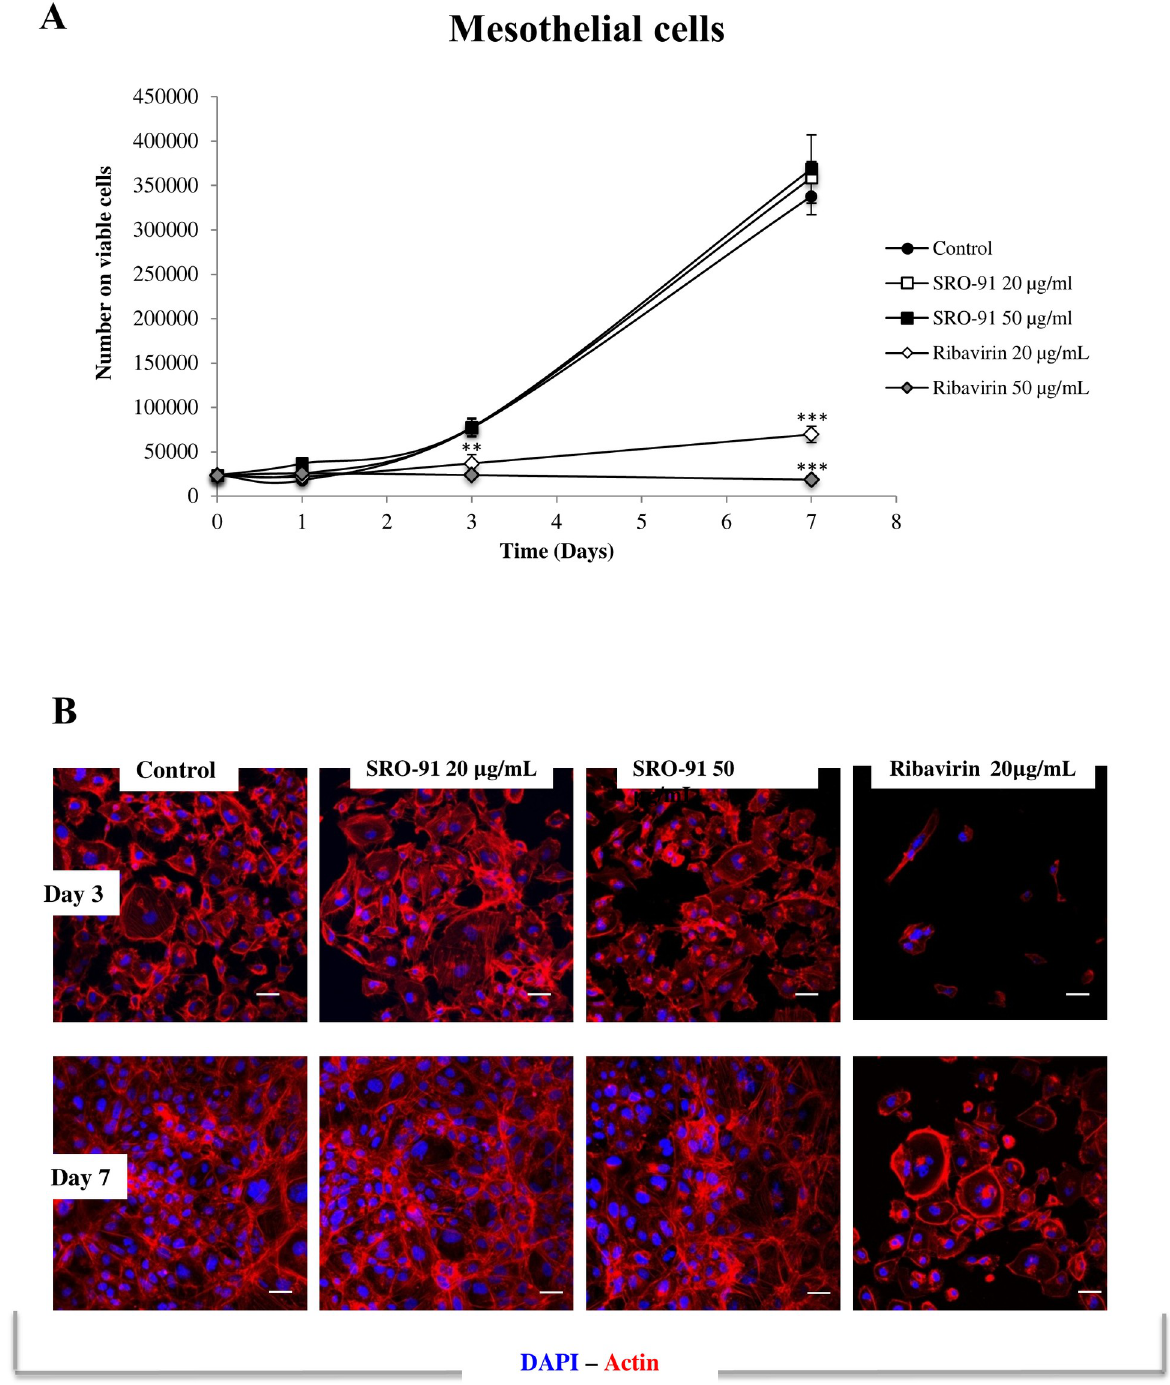
Fig 10. Viability and cell morphology of healthy mesothelial cells after SRO-91 or ribavirin treatment. (A) Mesothelial cells were exposed to ribavirin analog SRO-91 or ribavirin at 0, 20 or 50 μ g/mL for 7 days of culture. The number of viable cells was measured daily by the trypan-blue exclusion test. Results are representative of at least three independent experiments performed in triplicate and are expressed as mean ± standard deviation. P-values were calculated by Paired one-way ANOVA test ( �� P < 0.01, ��� P < 0.001). (B) Immunofluorescent staining of actin cytoskeleton expressed by mesothelial cells after SRO-91 or ribavirin treatment or without treatment (control). Cell nuclei were stained with DAPI. Staining was examined with laser scanning confocal microscopy. Scale bar is 50 μ m.